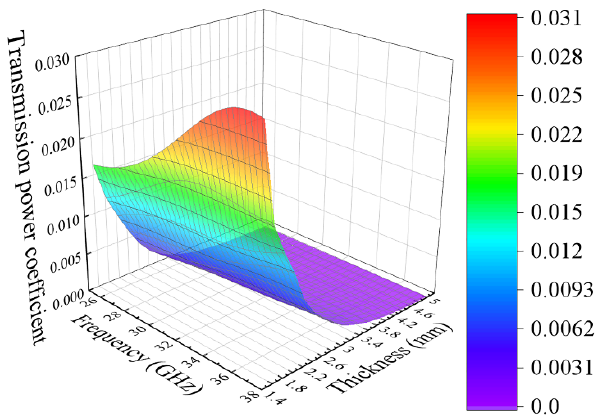
Figure 8. The dependences of the transmission coefficient on wave frequency and plate thickness for the composite with 30% flakes.